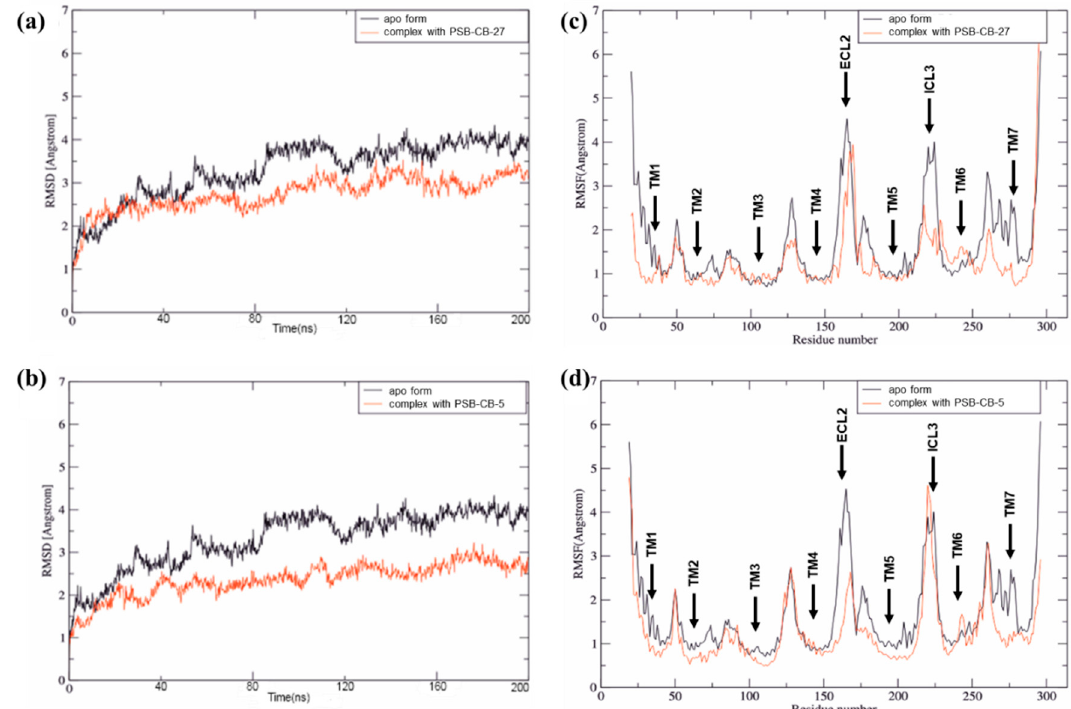
Figure 4. ( A , B ) Root mean square deviation (RMSD) curves for the 200 ns MD simulation runs of the GPR18 complex with antagonist 4 ( A ) and antagonist 5 ( B ). ( C , D ) Root mean square fluctuation (RMSF) curves of the molecular dynamics (MD) simulation for complexes with antagonist 4 ( C ) and 5 ( D ). Curves of the complexes are colored in orange, and the curve of the apo form of the receptor in black.